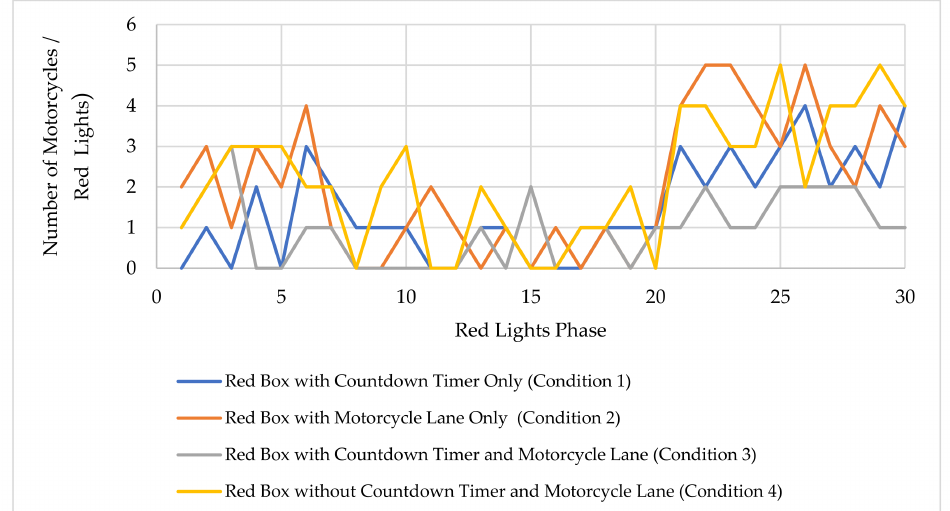
Figure 9. Stop line violation in every green